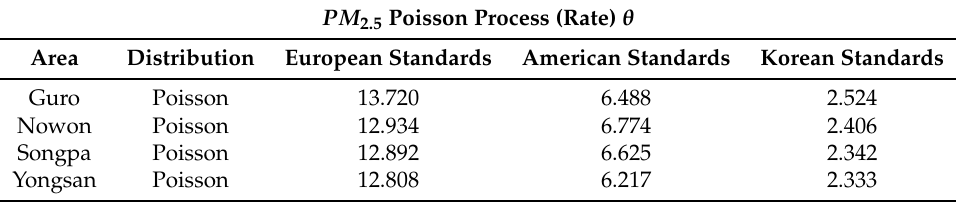
Table 7. PM 2.5 Poisson Process.